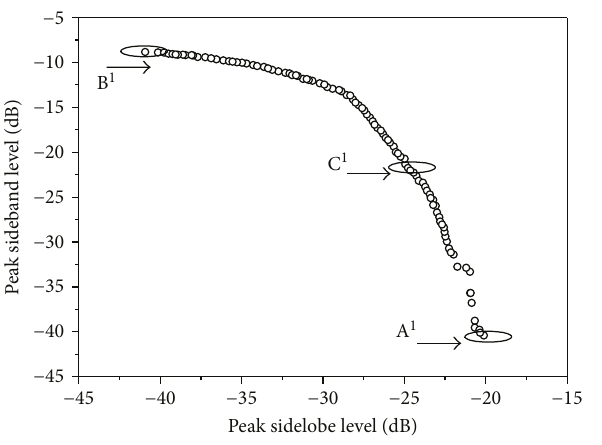
Figure 3: The Pareto front for case 1. Table 2: Performances of three individuals in case 1.